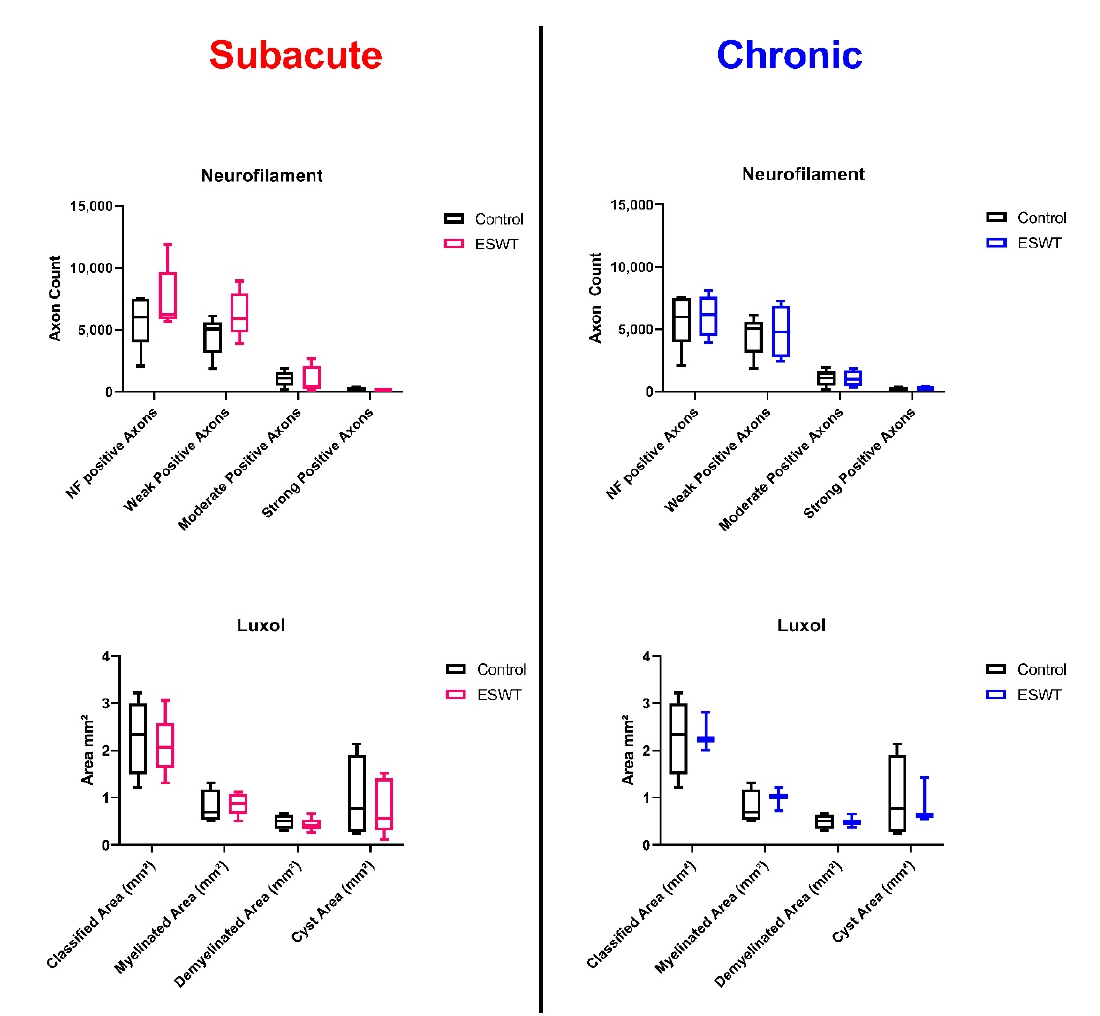
Figure 5. Box and whisker plots of histological stainings. In Figure 5, box and whisker plots (minimum to maximum, with Q1, Median and Q3) illustrate the differences between control (black) and chronic (blue), as well as subacute (red) treatment groups.